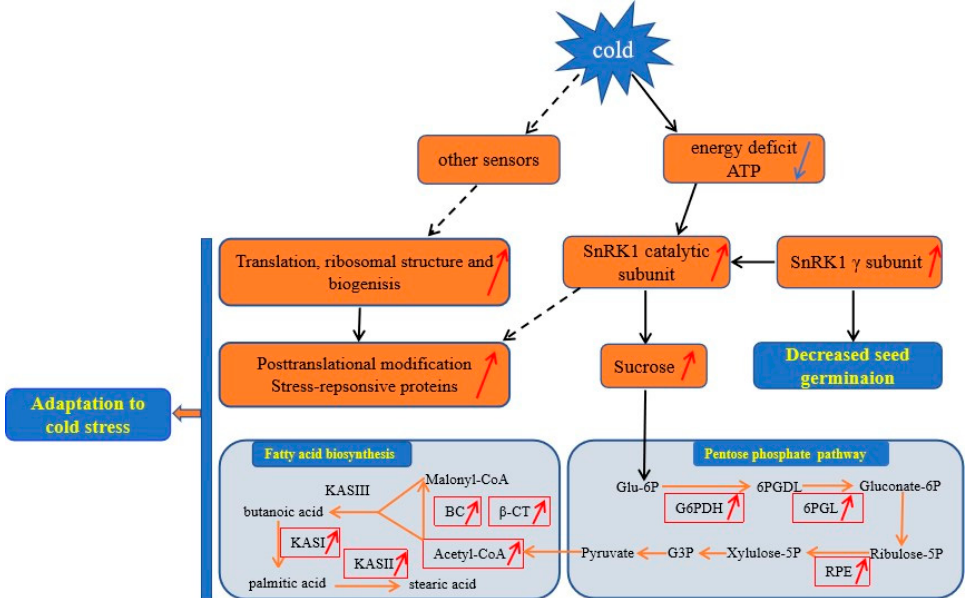
Figure 5. A proposed model for Ricinus communis during early seed imbibition in response to cold stress. The up-accumulated DAPS and increased content of acetyl-CoA and sucrose were indicated by the red arrow; the decreased content of ATP were indicated by blue arrow. Abbreviations: Glu-6P, Glucose 6-phosphate; 6PGDL, 6-phosphogluconolactone; G6PDH, glucose-6-phosphate 1-dehydrogenase; 6PGL, 6-phosphogluconolactonase; Gluconate-6P, 6-phosphogluconate; Ribulose-5P, Ribulose-5-phosphate; Xylulose-5P, Xylulose-5-phosphate; RPE, Ribulose-phosphate 3-epimerase; G3P, Glyceraldehyde 3-phosphate; KASI, β -ketoacyl-acyl carrier protein synthase I; KASII, β -ketoacyl-acyl carrier protein synthase II; KASIII, β -ketoacyl-acyl carrier protein synthase III. Solid lines denoted proven connections in plants, whereas broken lines represented connections that might exist in plants.